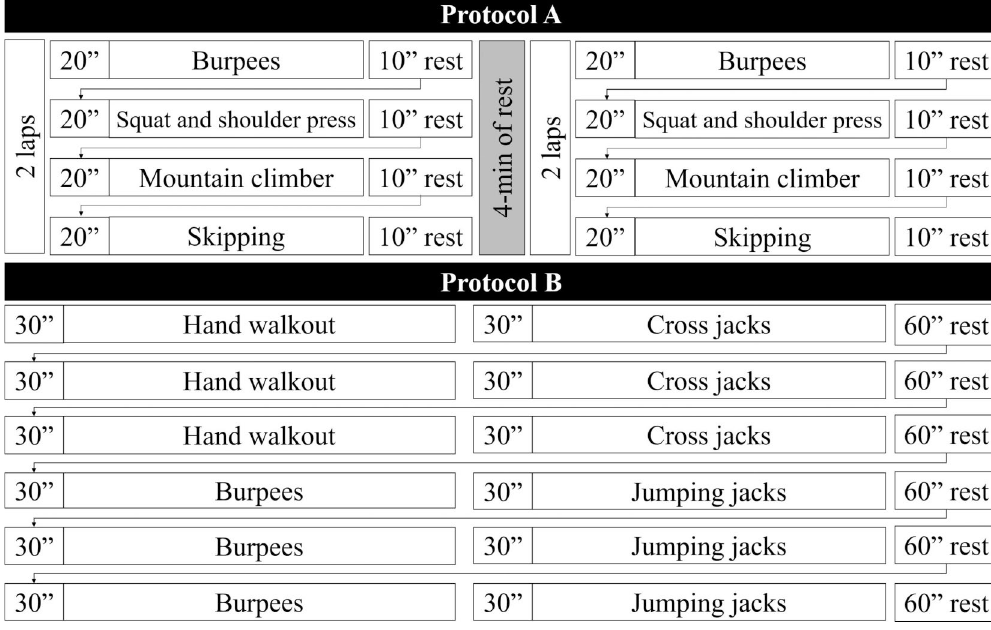
Figure 2 - Training